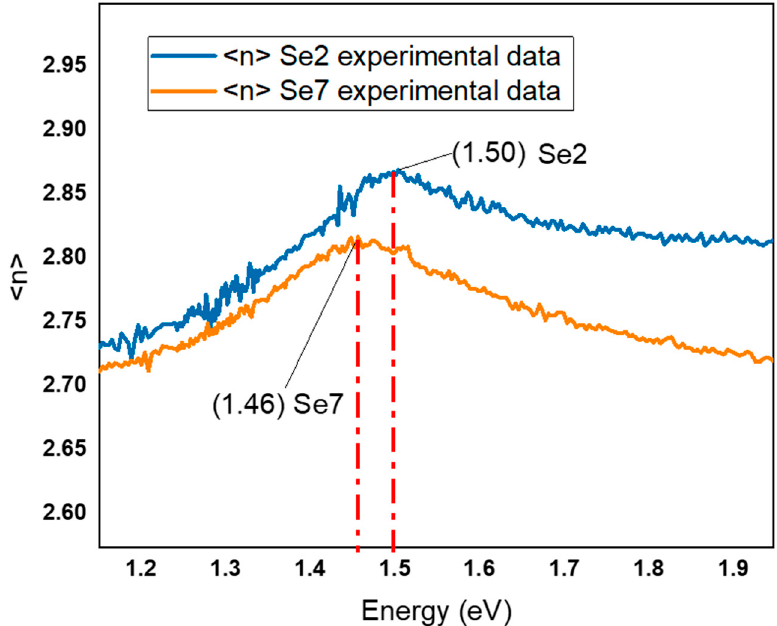
Figure 5. The energy dependence of the optical refractive index n and the calculation of its associated bandgap for samples at different concentrations of selenium, Se2 and Se7.